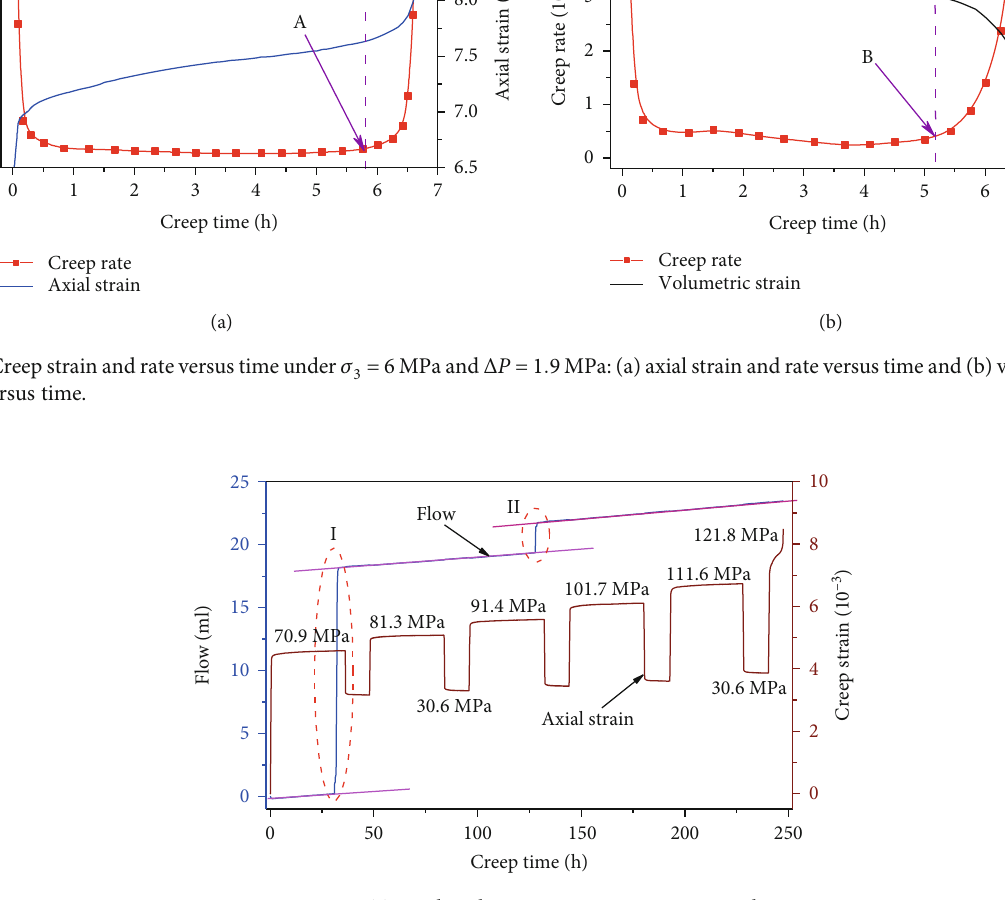
Figure 8: Triaxial multistage creep-seepage test